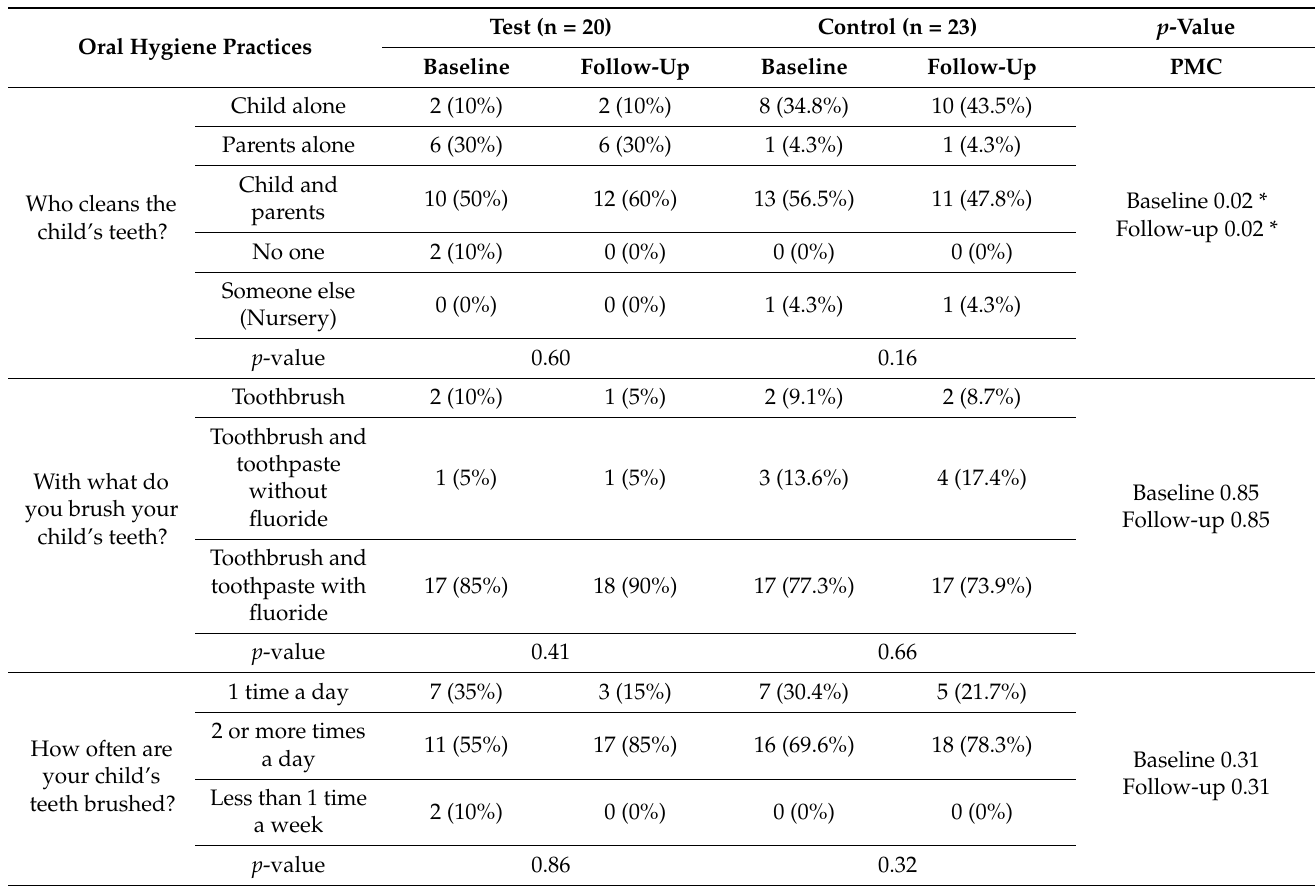
Table 3. Child’s oral hygiene practices at baseline and follow-up in two study